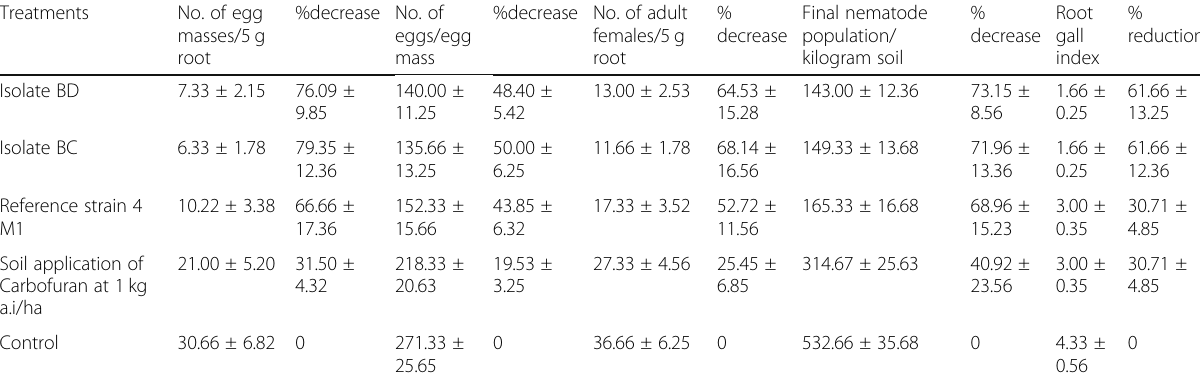
Table 2 Biocontrol potential of native Bacillus thuringiensis against root knot nematode Meloidogyne incognita in tomato